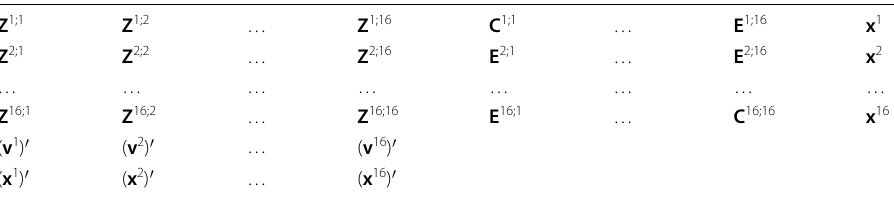
Table 1 Simplified pattern of the